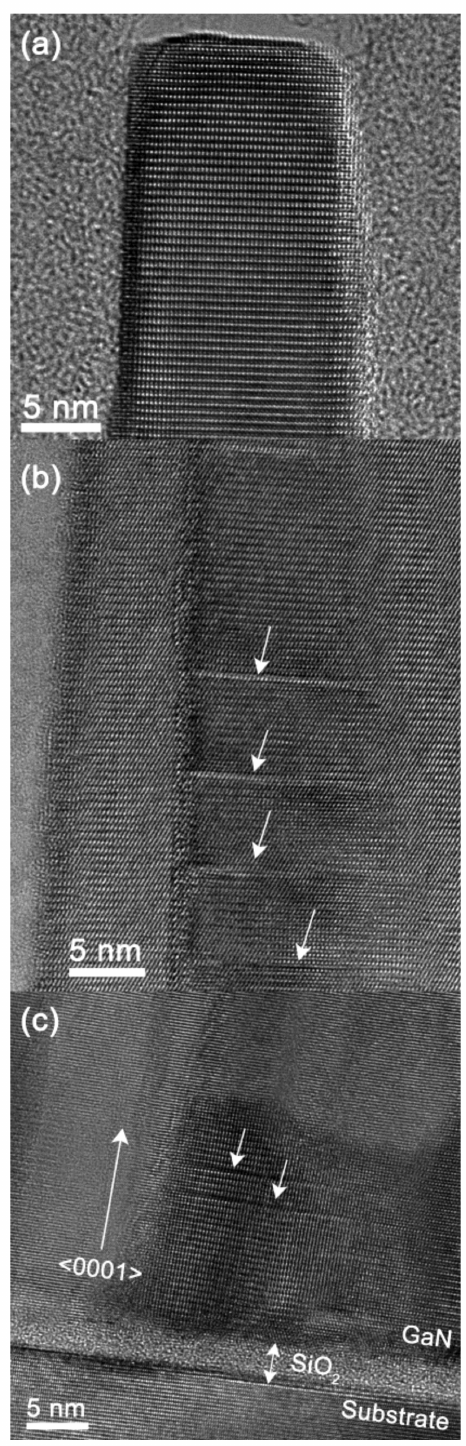
Figure 6. Cross-sectional HRTEM images from a GaN nanorod grown at P N2 = 4.5 mTorr on Si(111) substrate showing ( a ) the top part of the nanorod; ( b ) the middle part of the nanorod with stacking faults indicated by the arrows; and ( c ) the interface between the substrate and nanorods, containing the native oxide layer at the interface. Stacking faults close to the interface are indicated by